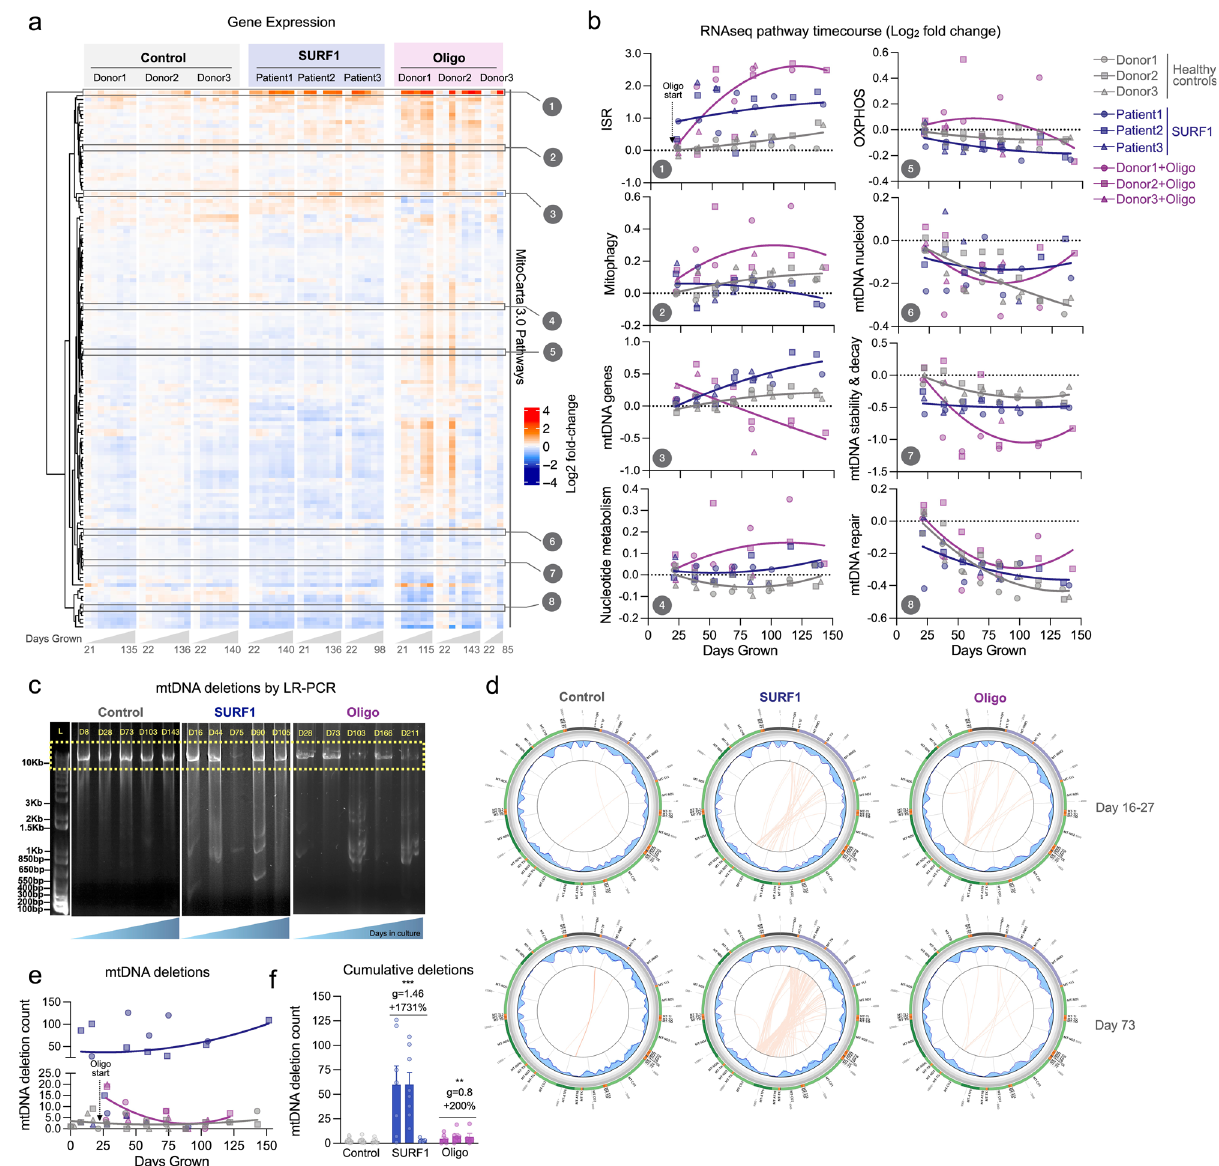
Fig. 4 Longitudinal mtDNA deletion pro fi les in OxPhos de fi cient SURF1 and Oligo cells. a RNAseq gene expression results for all MitoCarta 3.0 pathways, plus all mtDNA genes, and the integrated stress response (ISR: average of ATF4, ATF5, CHOP, GDF15). Values for each pathway are computed from the average expression levels of all genes in each pathway, expressed as the median-centered value relative to the youngest control timepoints for each pathway (rows). Each column represents a single timepoints ( n = 3 – 8) along the lifespan of each donor or treatment condition ( n = 3 donors, 3 groups). b Gene expression time course of selected mitochondrial pathways from E, expressed on a Log2 scale relative to the fi rst control timepoint (baseline). c 10 kb long-range PCR product resolved by agarose gel electrophoresis for control fi broblasts cultured up to 166 days (P3 to 31), and passage- matched SURF1 and Oligo-treated cells. d Results from mtDNA sequencing and Eklipse analysis. Each line in the circos plots depicts a deletion burden in control (Donor2) and SURF1 (Patient2) and Oligo-treated (Donor2) cells from two (early and mid-lifespan) representative passages. e Timecourse of the number of unique mtDNA deletions in control, SURF1, and Oligo-treated cells. Deletion counts were estimated with a variant call cutoff of >5% heteroplasmy. f Total deletion burden in cells across 150 days of lifespan. Data are mean ± SEM. ** P < 0.01, *** P < 0.001, mixed effects model ( fi xed effect of Control/SURF1/Oligo group and days grown, random effects of donor or cell